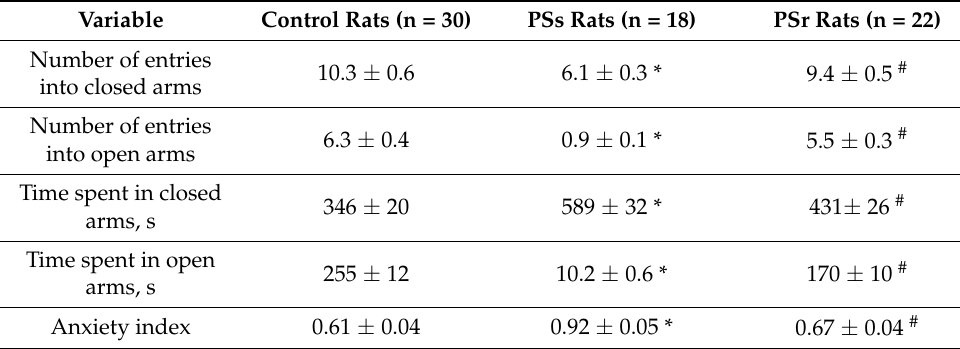
Table 1. Behavioral data from elevated plus maze